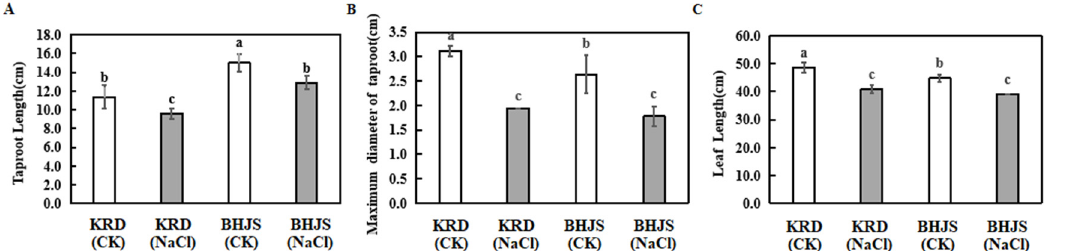
Figure 2. Morphological parameters of carrot under salt stress. ( A ) Taproot length; ( B ) Maximum diameter of taproot; ( C ) Leaf length. Different lowercase letters indicate significant differences among different carrot cultivars and treatment at the p < 0.05 level.